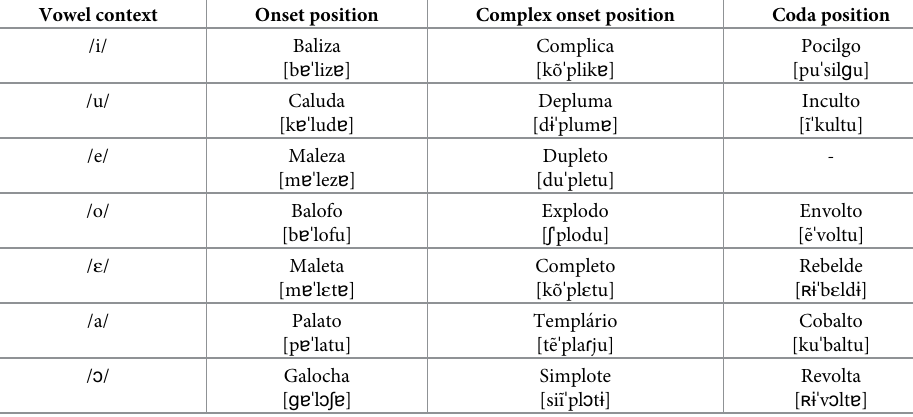
Table 1. The corpus used in the data